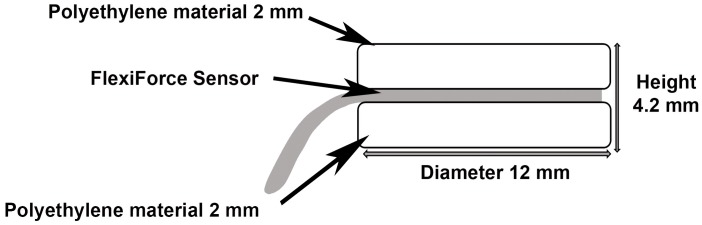
Schematic drawing of custom-made bite force device set up.